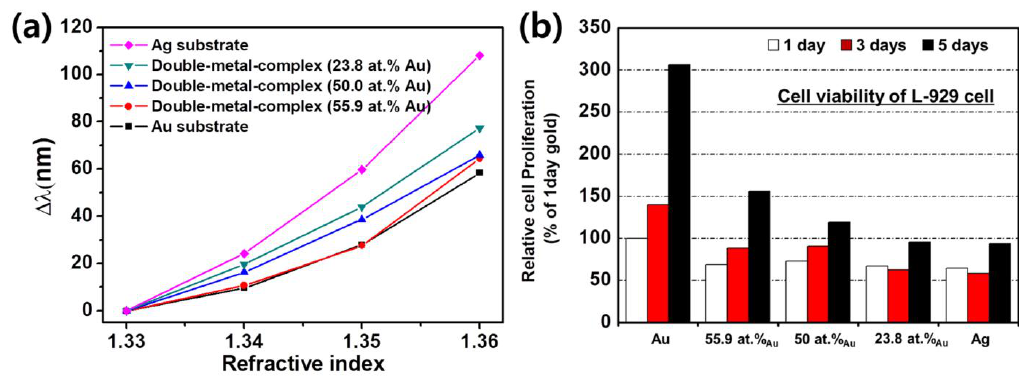
Figure 6. ( a ) The measured resonance peak shifts from RI differences on nanowire-patterned double-metal-complex substrates with various compositions. As the resonance peak shifts show, the patterned silver substrate presents the highest sensitivity. For the patterned double-metal-complex substrates, the sensitivity was improved as the composition of gold is decreased; ( b ) The cell viability assay results for testing the cell affinity of each substrate when culturing the cell on those substrates for a day, 3 and 5 days. The higher proportion of gold substrate enhances cell viability, also, the cell viability of the 23.8% gold substrate was similar to that of the silver substrate.